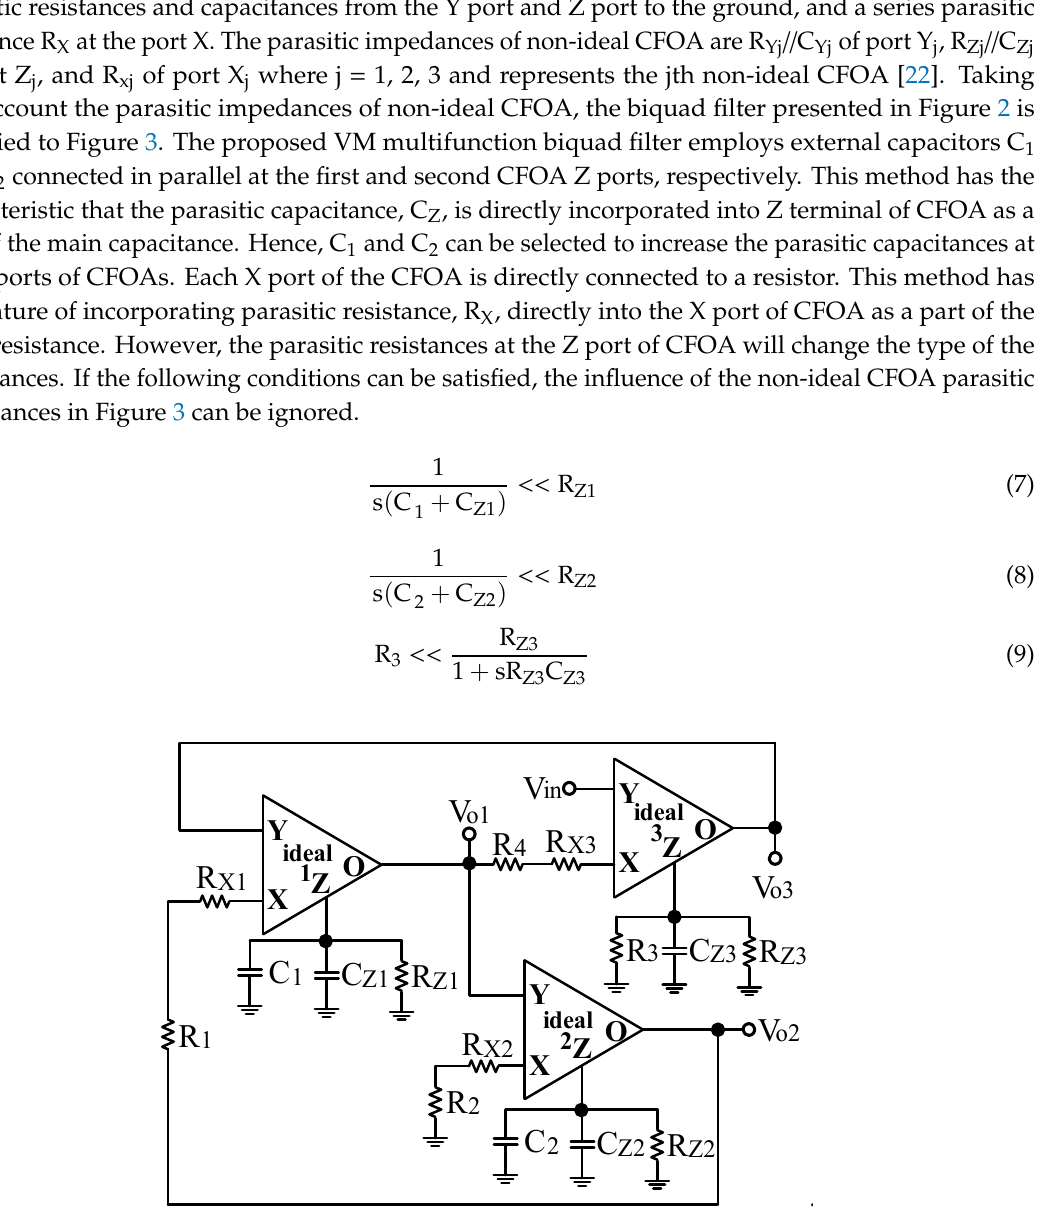
Figure 3. Proposed VM multifunction biquad filter including the CFOA parasitic impedances.